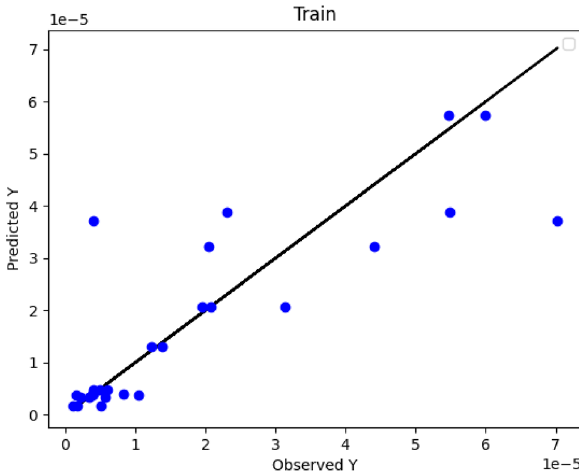
Figure 2. DT Model: actual versus predicted values/Y: